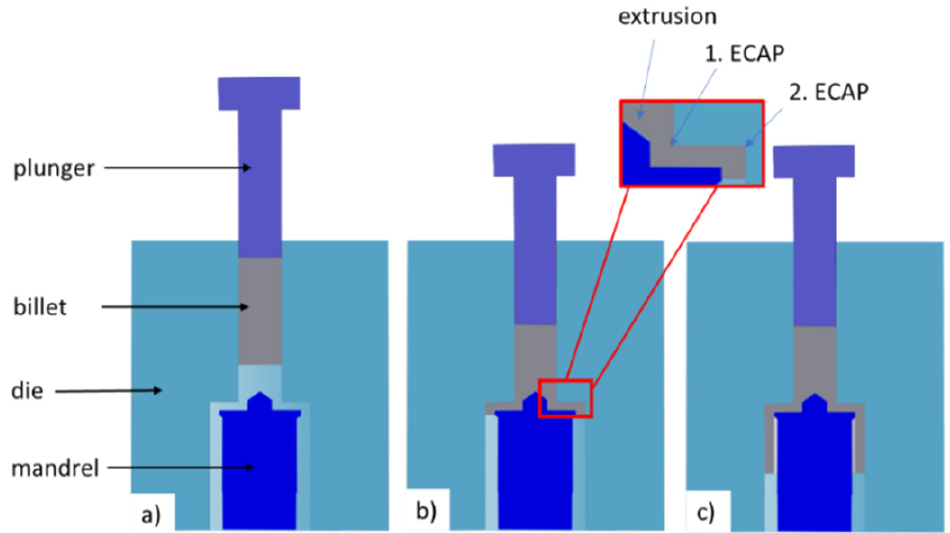
Figure 1. Schematic illustration of individual stages in the CSET process. ( a ) start of CSET; ( b ) situation after extrusion and 2nd ECAP pass; ( c ) final stage of CSET.